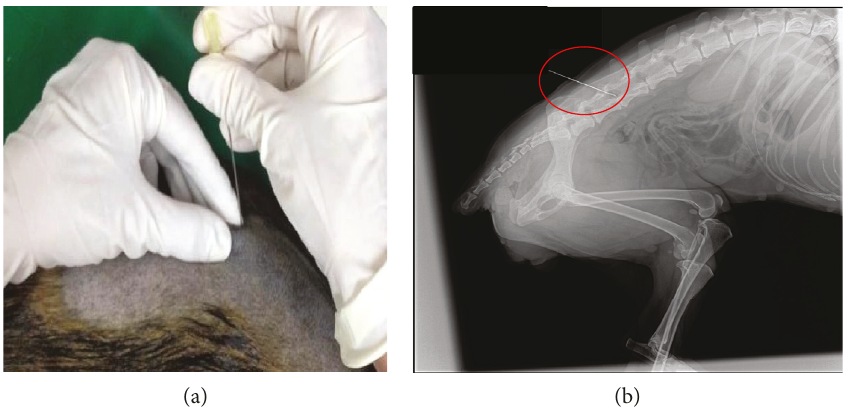
Figure 2: Localization of the injection site. (a) Photograph depicting the procedure of percutaneous injection. (b) X-ray image of the vertebral column, highlighting the a ff ected intervertebral